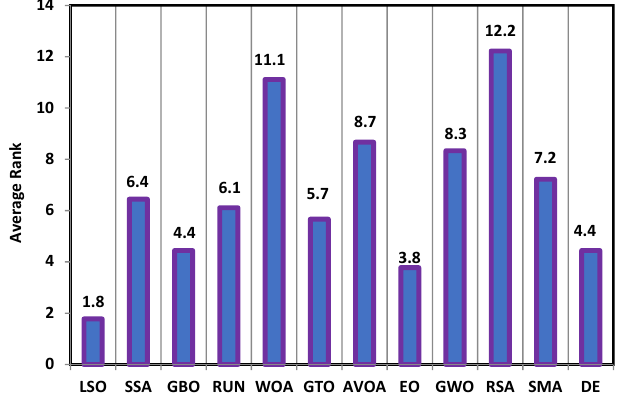
Figure 13. Average rank of each optimizer on all CEC2020.